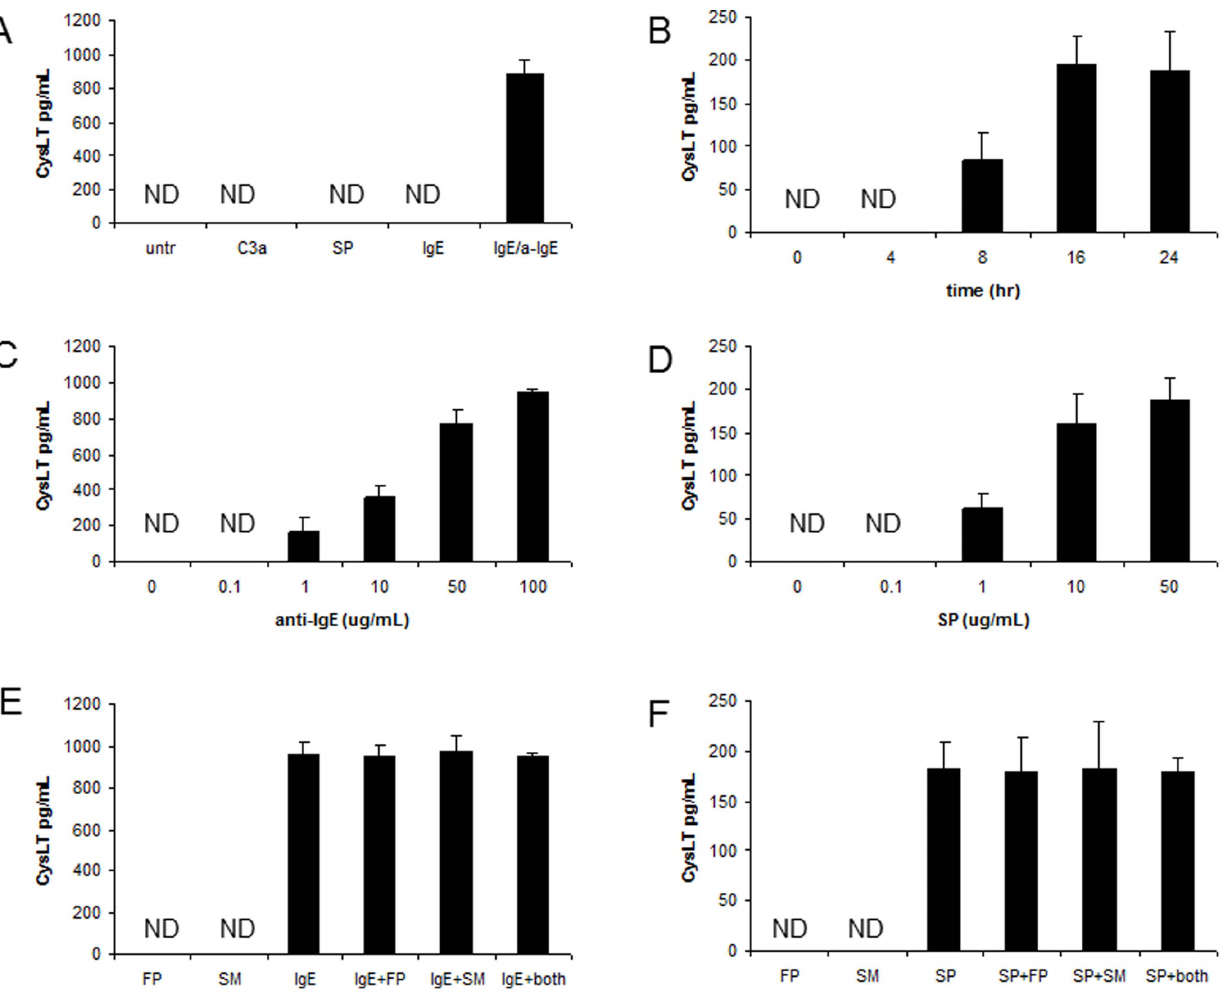
Figure 7. Fluticasone and salmeterol had no effect on Fc e RI- and SP-mediated production of cysteinyl leukotrienes. A , LAD2 mast cells were stimulated with C3a (100 ng/mL), SP (1 ug/mL), IgE (0.5 ug/mL) or IgE/anti-IgE (100 ug/mL) for 4 hr and CysLT production was measured by ELISA. B , LAD2 mast cells were stimulated with SP (1 ug/mL) for the indicated times and CysLT production was measured by ELISA. C , LAD2 mast cells were sensitized with IgE (0.5 ug/mL) and stimulated with anti-IgE (100 ug/mL) for 4 hr and CysLT production was measured by ELISA. D , LAD2 mast cells were stimulated with SP for 16 hr and CysLT production was measured by ELISA. E , LAD2 mast cells were sensitized with IgE (0.5 ug/mL), treated with fluticasone (0.1 uM) or salmeterol (1 uM) for 20 hr, stimulated with anti-IgE (100 ug/mL) for 4 hr and CysLT production was measured by ELISA. F , LAD2 mast cells were treated with fluticasone (0.1 uM) or salmeterol (1 uM) for 20 hr and stimulated with SP (1 ug/mL) for 16 hr and CysLT production was measured by ELISA. (n=3, *=p ,